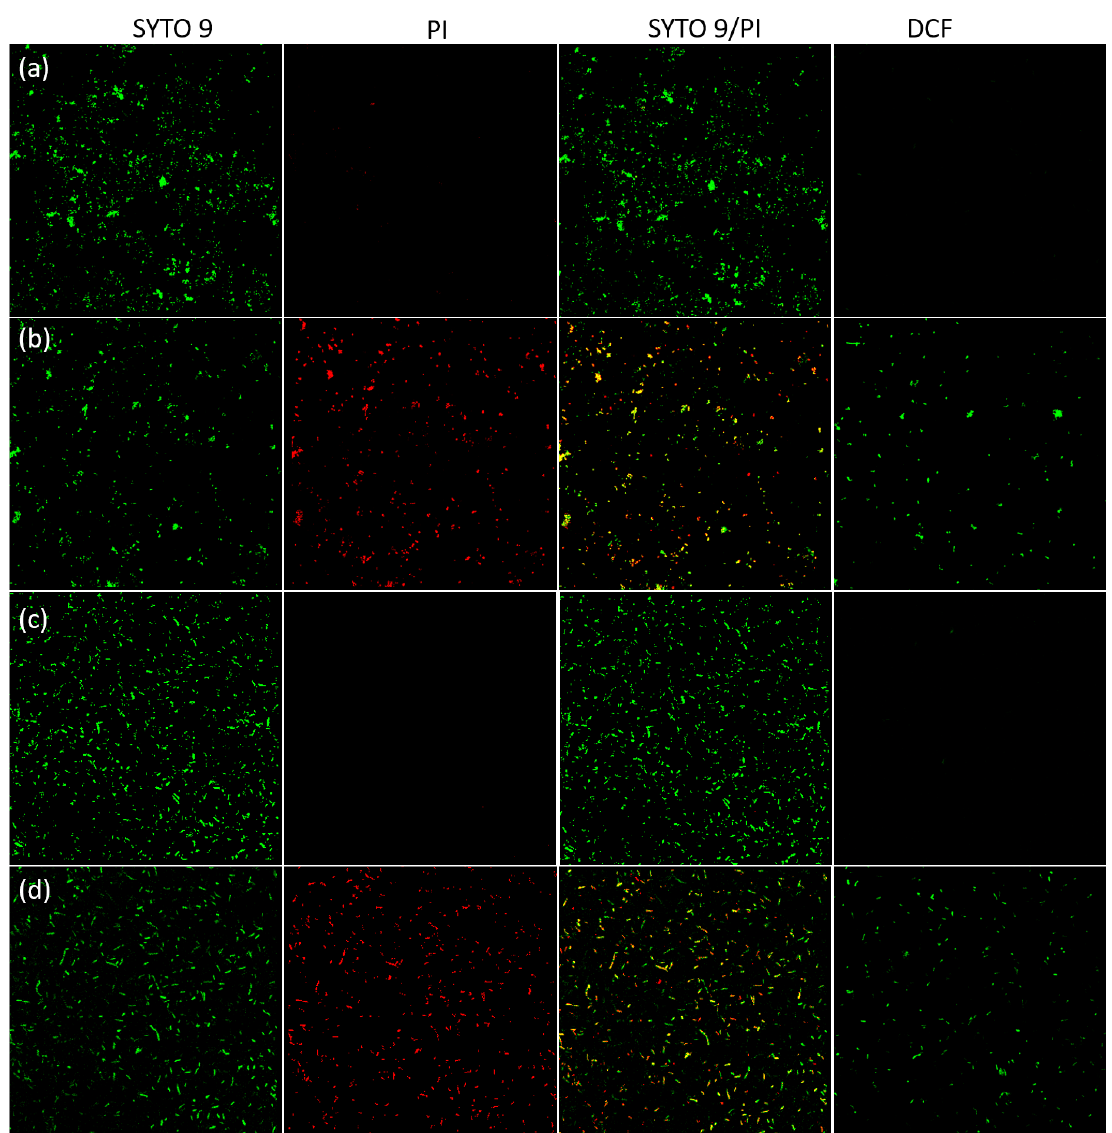
Figure 8. BacLight Viability assay (SYTO 9/PI) and ROS detection assay (DCF) CLSM images showing the S. aureus and E. coli ( a , c ) control and after treatment with ZnO/TiO 2 /AgNCs for 1 h ( b , d ). The merged images of SYTO 9/PI emit green fluorescence for viable cells while red:green indicates almost 60% of cell death. DCF emitted green fluorescent confirming the ROS generation on the treated cells ( b , d ) and no ROS were detected in control bacteria ( a , c ).